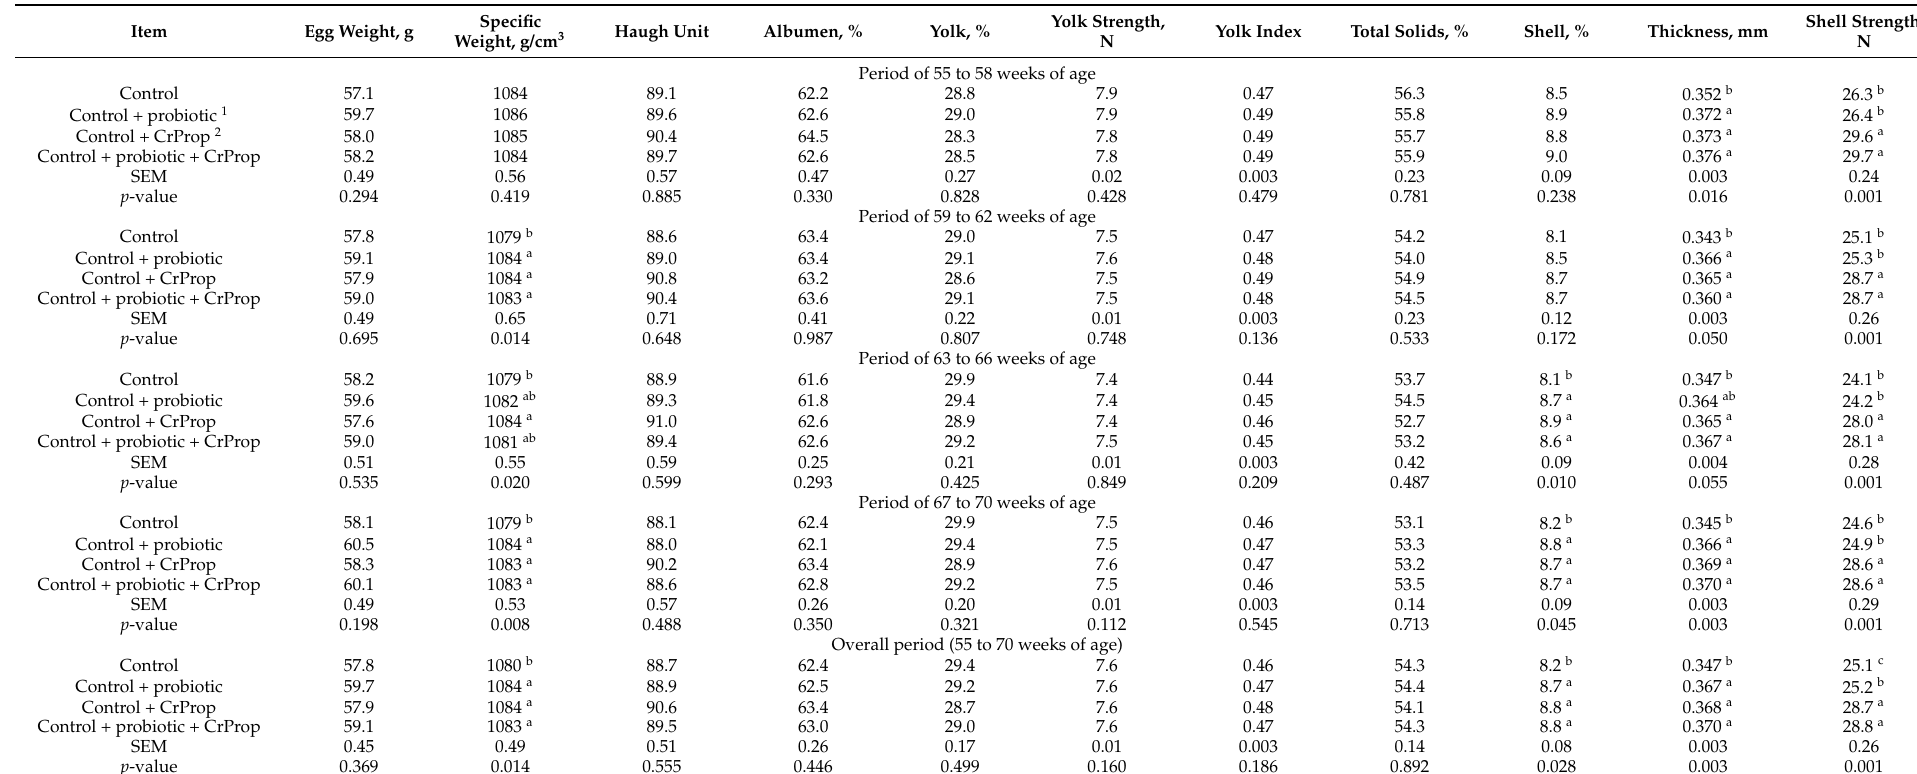
Table 3. Egg and eggshell quality of layer breeders fed diets supplemented with the probiotic and chromium propionate from 55 to 70 weeks of